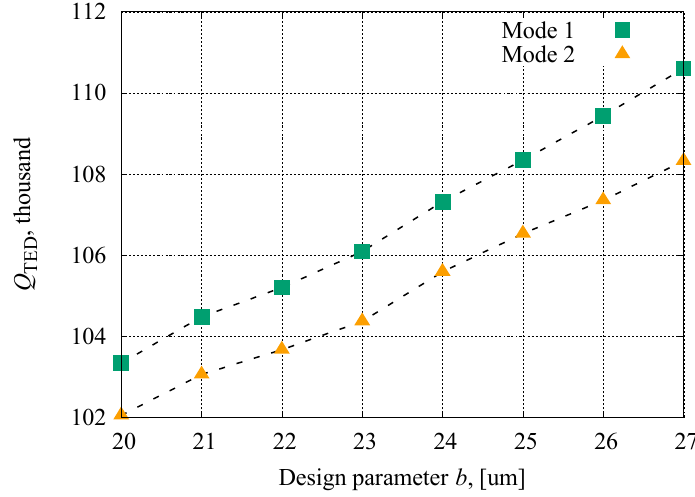
Figure 6. Q TED of Mode 1 and Mode 2 under different parameter b .